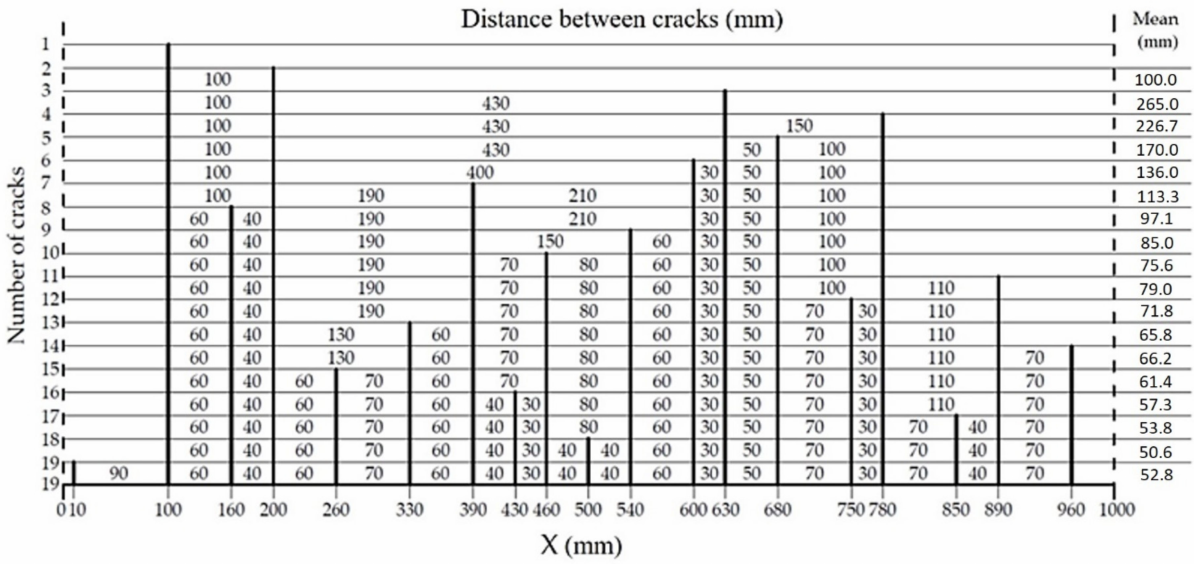
Figure 24. Summary of distances between cracks while loading beam